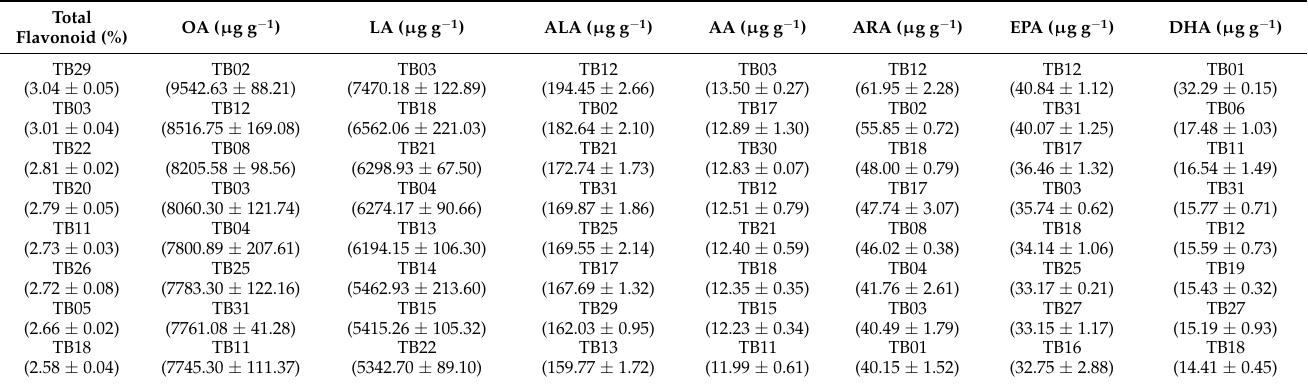
Table 2. The top 25% Tartary buckwheat accessions with total flavonoid, OA, LA, ALA, AA, ARA, EPA, and DHA content. OA, oleic acid; LA, linoleic acid; ALA, linolenic acid; AA, arachidic acid; ARA, arachidonic acid; EPA, eicosapentaenoic acid; DHA, docosahexaenoic